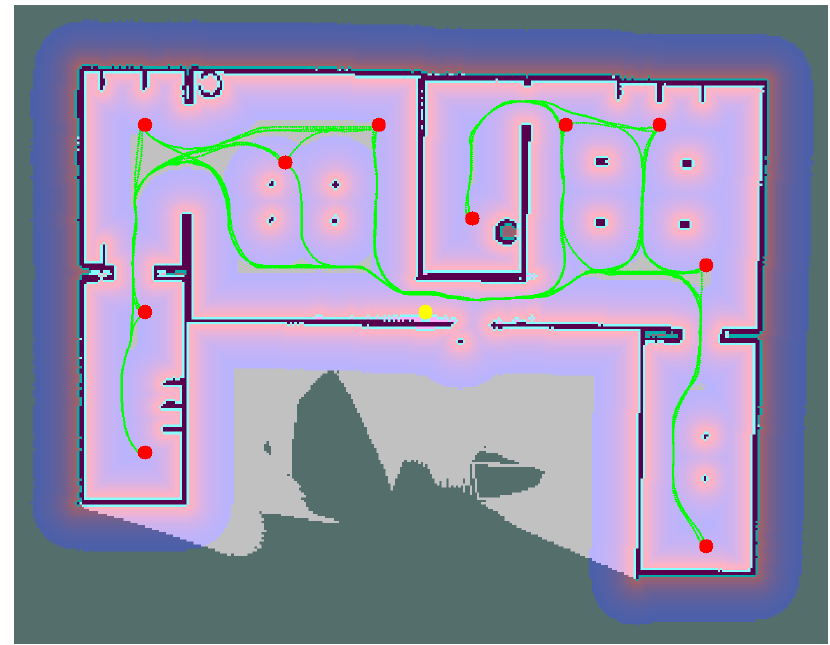
Figure 5. Map of the environment, cost map, start points and stop points marked with red, initial planned paths marked with green, and the origin of the coordinate system marked with yellow.